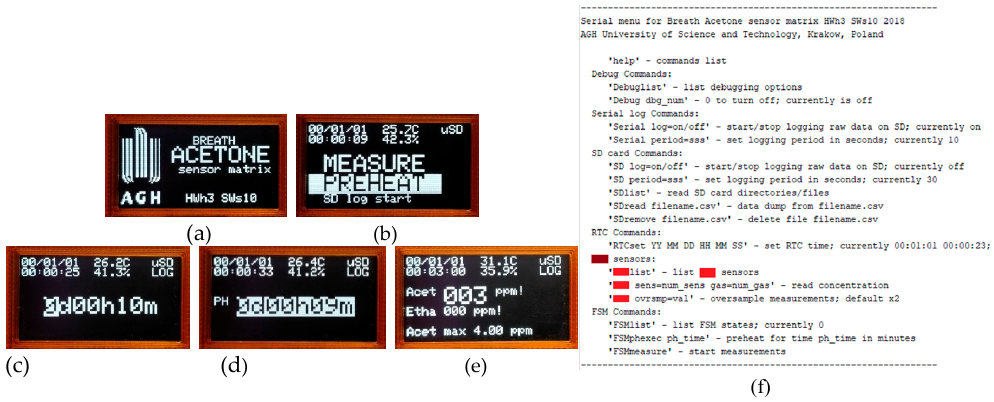
Figure 5. User interface screens of the developed portable gas analyzer. Splash screen ( a ), main menu ( b ), preheat setting ( c ), and executing ( d ) measurement screen presenting the acetone concentration ( e ) and the raw data from each sensor ( f ). Alternatively, the analyzer can be controlled through a serial interface ( g ).